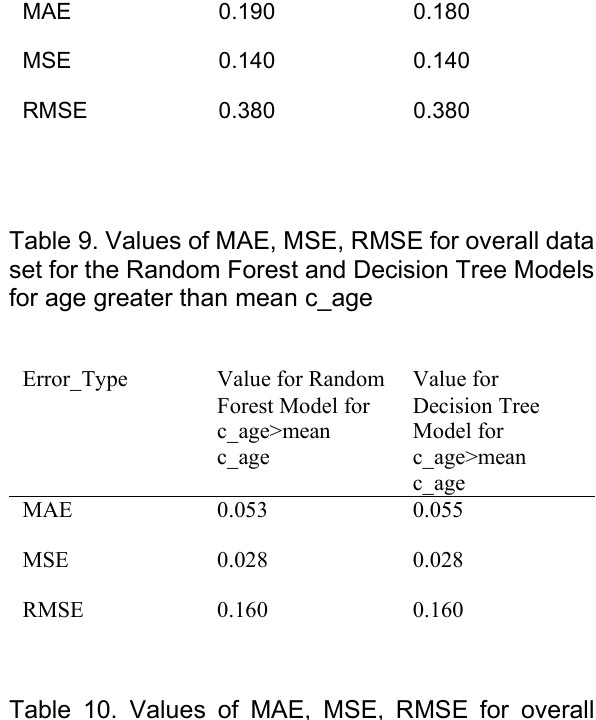
Table 10. Values of MAE, MSE, RMSE for overall data set for the Random Forest and Decision